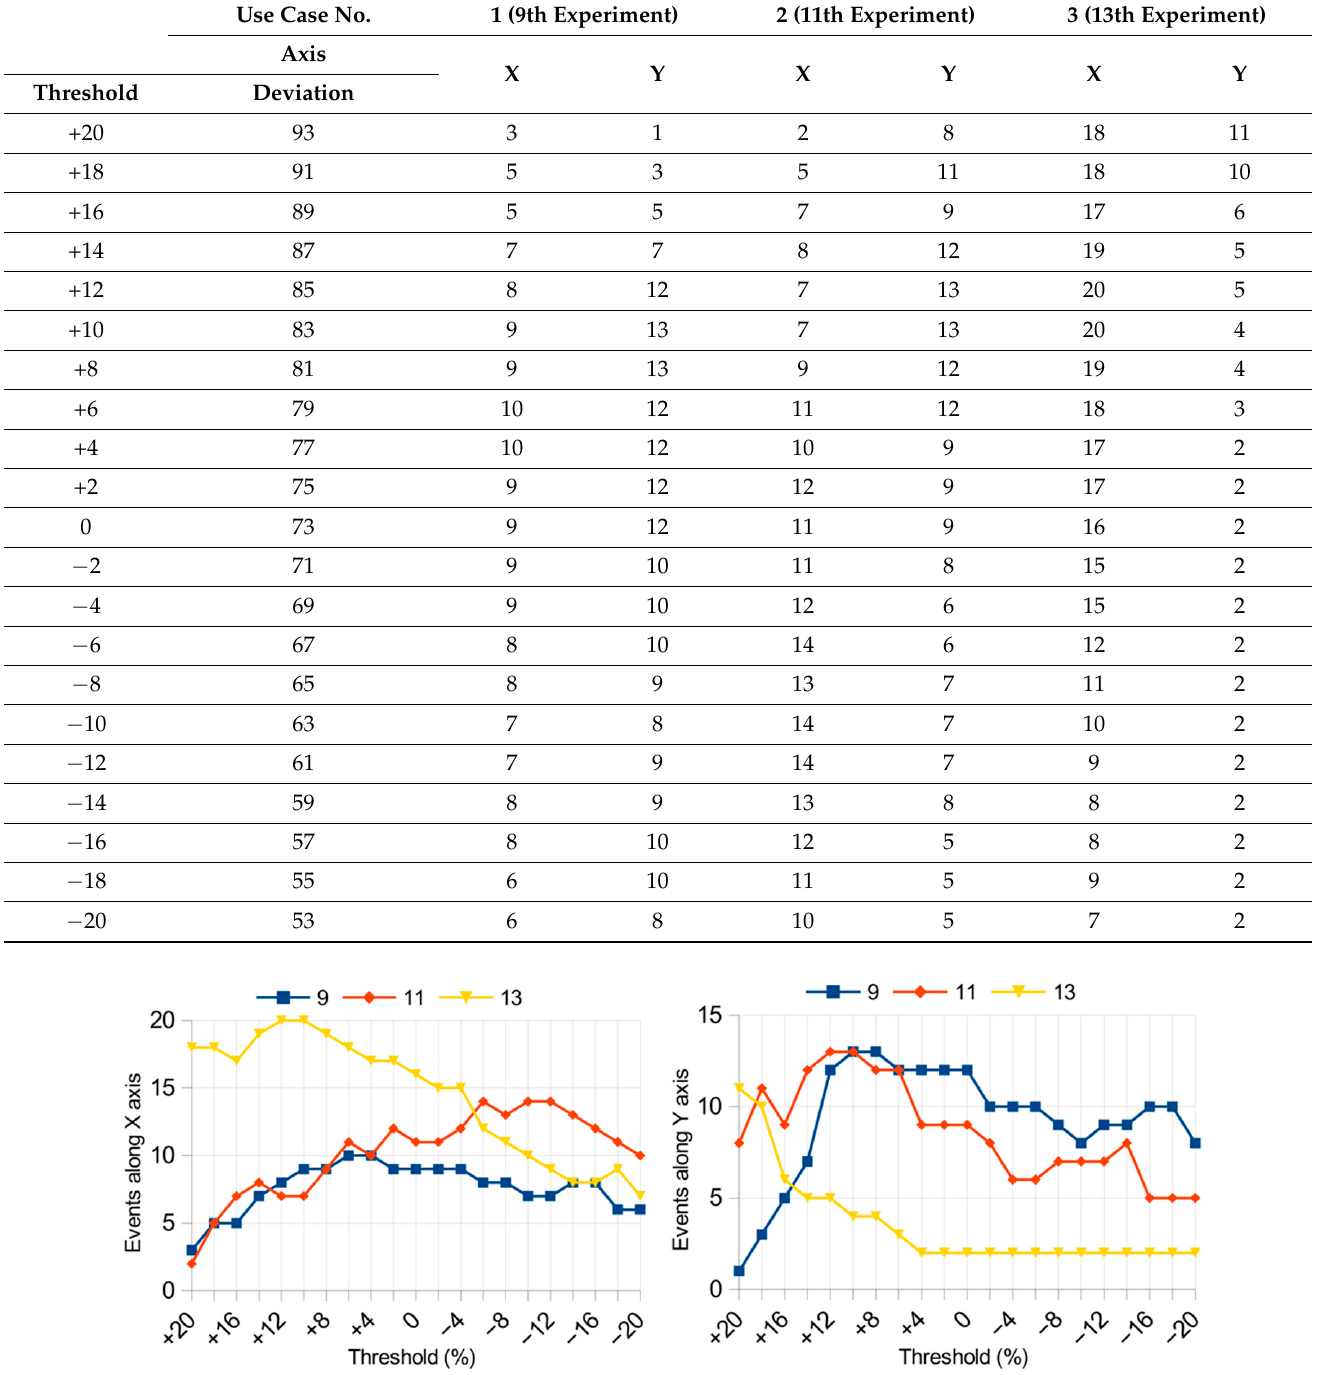
Figure 18. Comparison of all case studies for both X- and Y-axes.